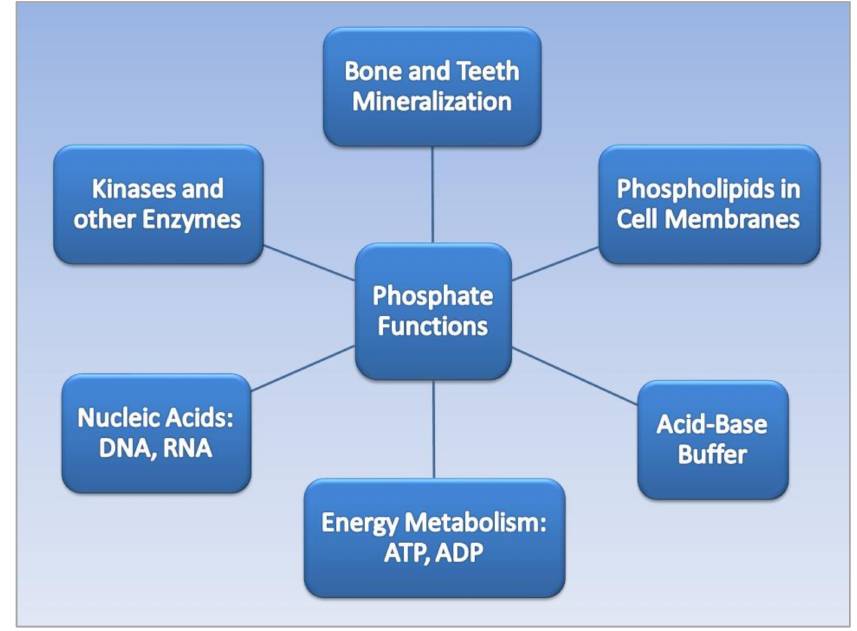
Figure 1. Phosphate functions in the human